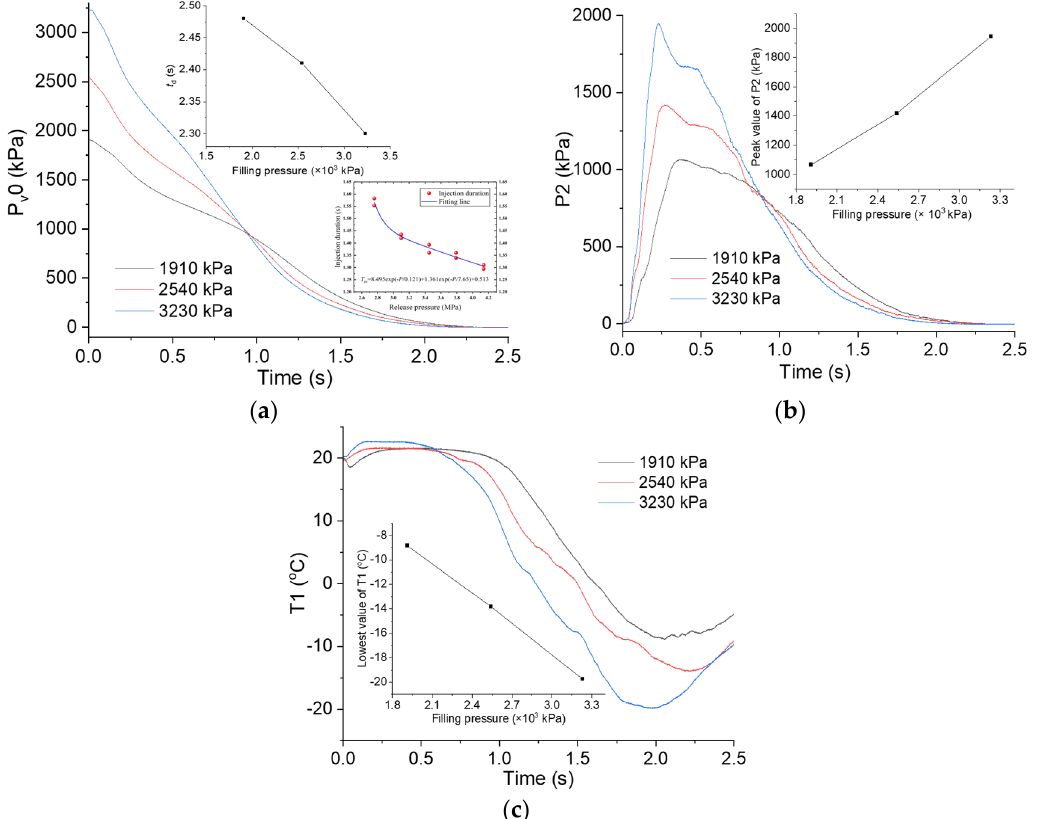
Figure 5. P–T profiles of the C 6 F 12 O tests at different filling pressures: ( a ) P v 0, the pattern inset in the upper part showed t d at different filling pressures, pattern inset in the lower part was due to the CF 3 Br from ref. [17]; ( b ) P2, the pattern inset showed the peak values of P2 at different filling densities; ( c ) T1, the pattern inset showed the T1 nadir at different filling